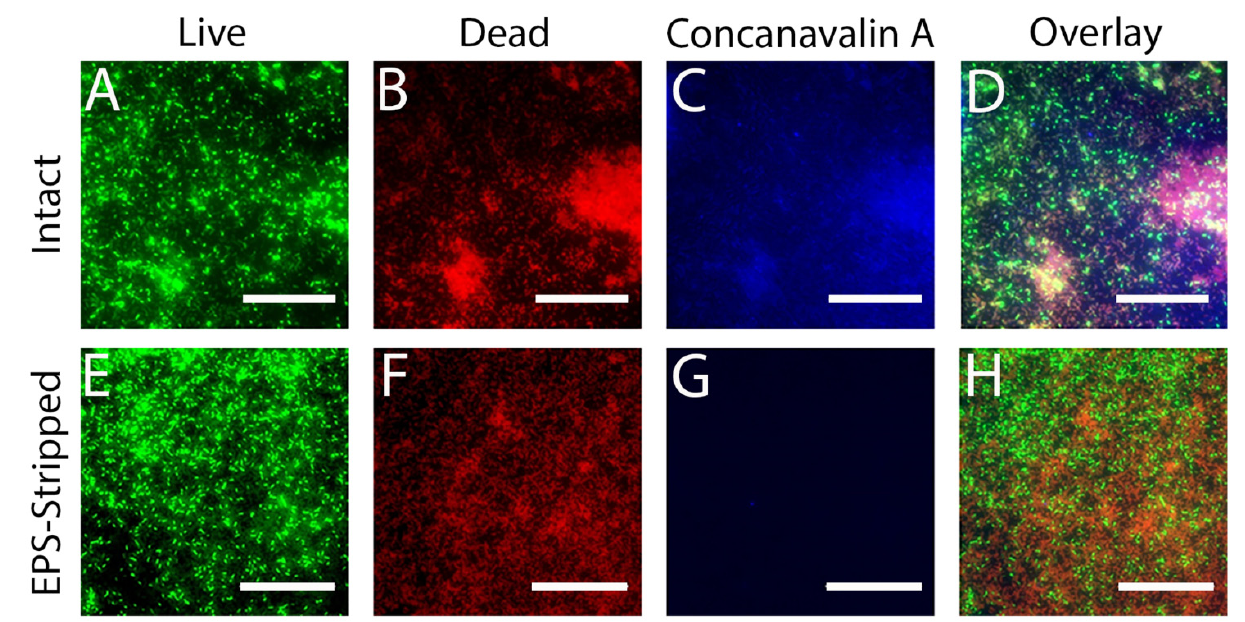
Figure 4. Representative images of intact ( A – D ) and EPS-stripped E. coli biofilms ( E – H ) stained with live/dead/concanavalin A (L/D/C) stain. ( A ) Cells stained by SYTO 9 in an intact biofilm. ( B ) Cells and eDNA stained by PI in an intact biofilm. ( C ) EPS in an intact biofilm stained by a fluorescent concanavalin A probe. ( D ) A merged image of panels ( A – C ). ( E ) Cells stained by SYTO 9 in an EPS-stripped biofilm. ( F ) Cells and eDNA stained by PI in an EPS-stripped biofilm. ( G )